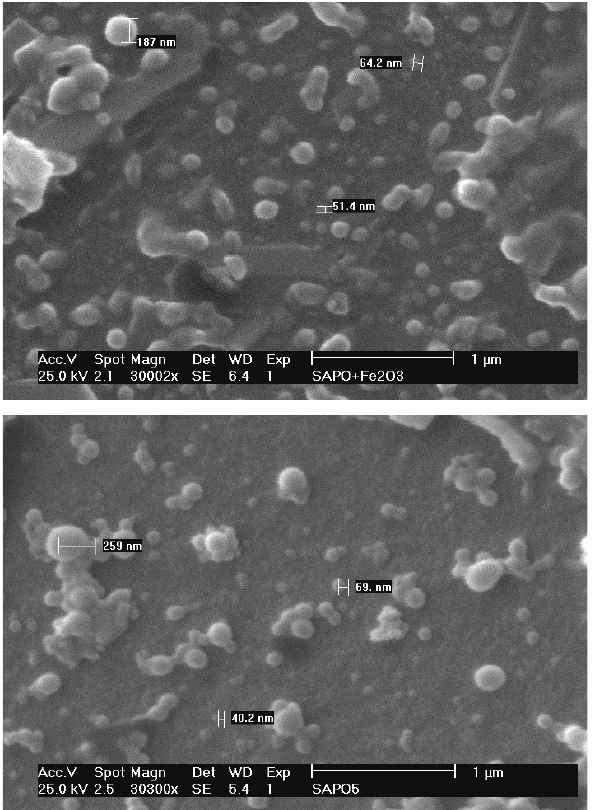
Figure 1: XRD powder patterns of α-Fe catalyst support.